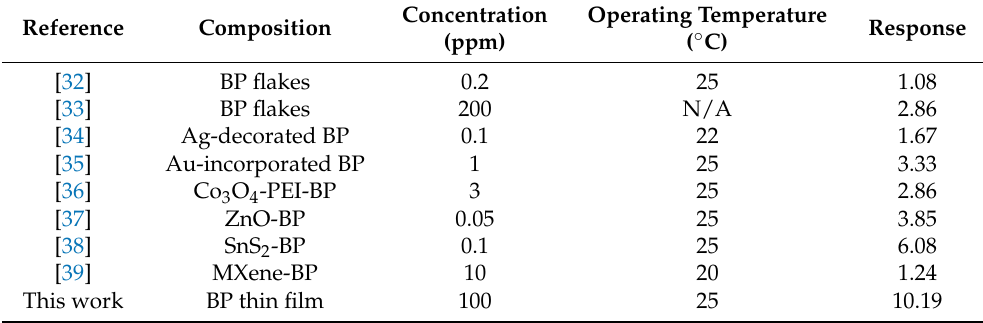
Table 1. Comparison of NO 2 sensing performances of the BP-based gas sensors.